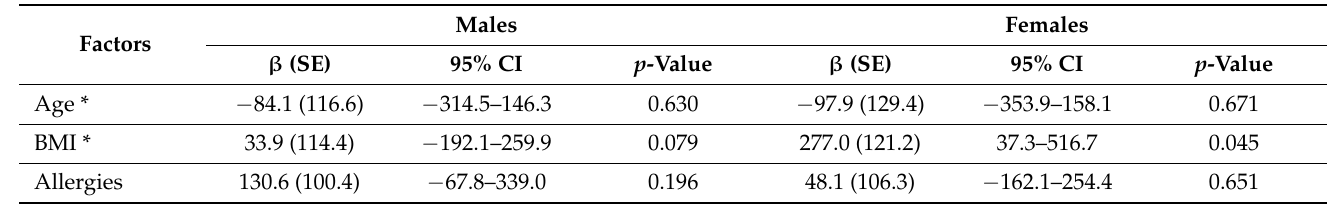
Table 4. Multivariable analysis of the association between anti-SARS-CoV-2 IgG and sample charac- teristics by